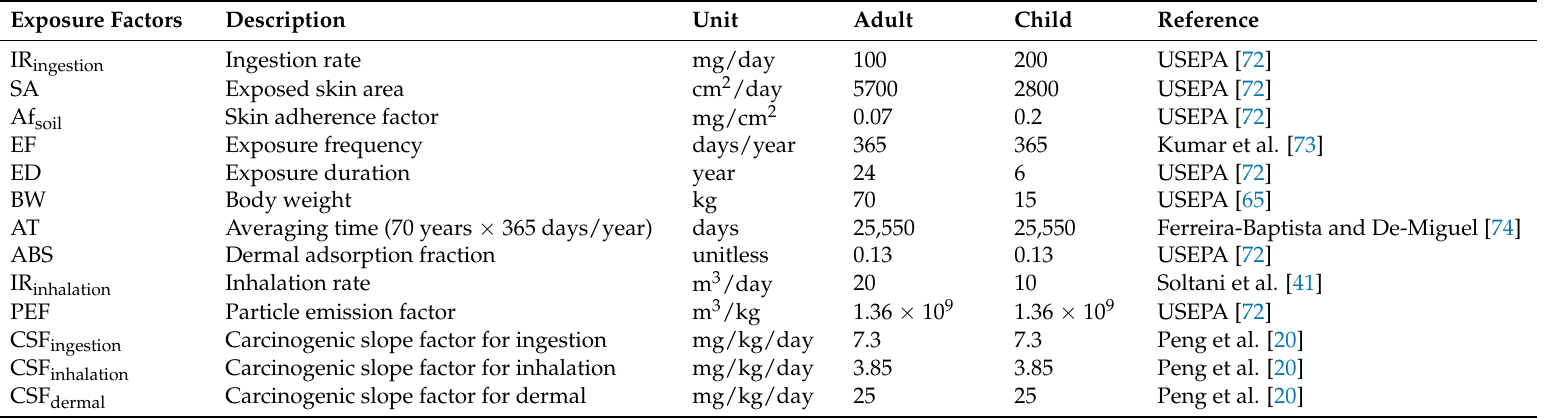
Table 1. Values of exposure parameters and factors used for the incremental lifetime cancer risk